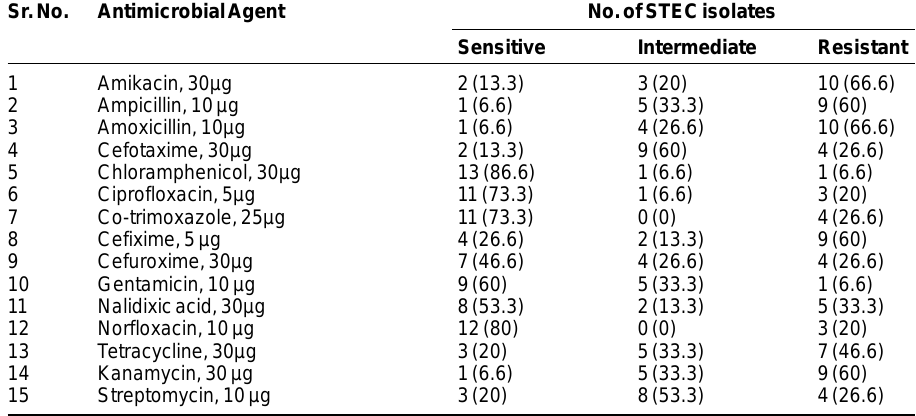
Figure-1. Agarose gel showing mPCR amplification products of stx , stx and eaeA genes. 1 2 Lane M: 100 bp molecular weight marker, Lane1 & 2: Amplified product of stx gene, 1 Lane 3: Amplified products of stx and eaeA genes, 2 Lane 4: Amplified products of stx and stx genes, 1 2 Lane 5: Amplified product of stx gene, 1 Lane 6: Amplified product of eaeA